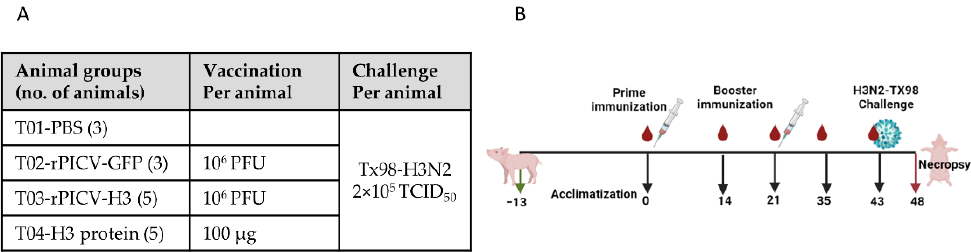
Figure 1. Animal study design ( A ) Table indicating different treatment groups that were included in the study along with dosage specification for vaccine and challenge virus. ( B ) schematic view of study schedule representing duration at which vaccination, challenge, and sample collections were carried out. Image was made using the Biorender tool.